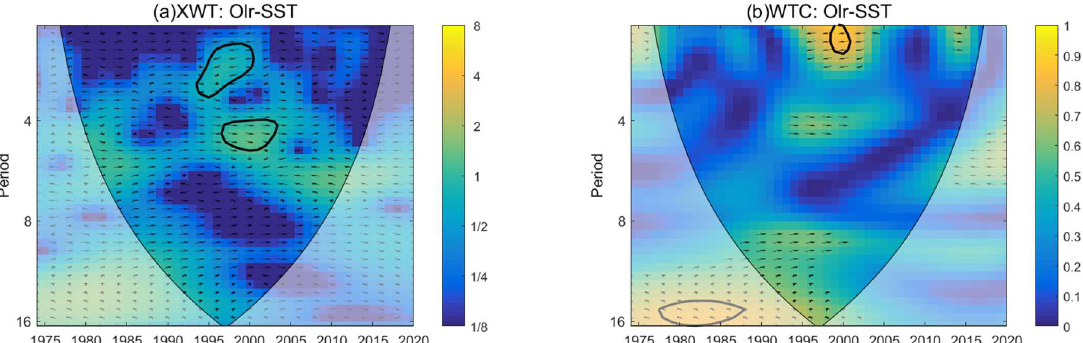
Figure 14. XWT of long-wave radiation and SST in the tropical western Indian Ocean. ( a ) energy spectrum; ( b ) condensation spectrum.